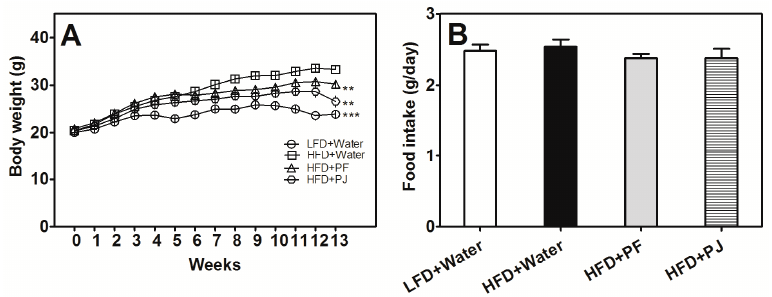
Table 3. Effects of PF and PJ extracts on weight of different tissues and serum lipids in high-fat diet (HFD) C57BL/6 mice.